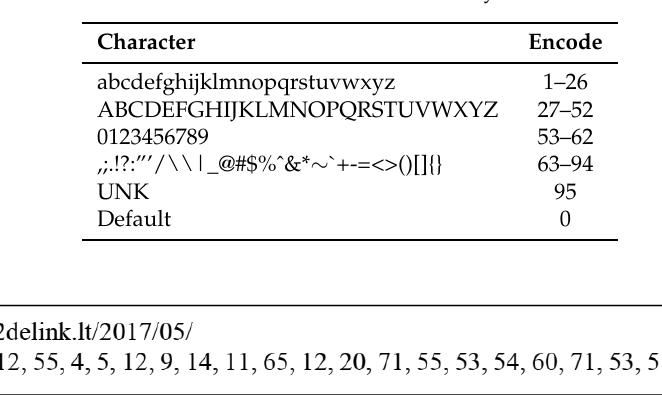
Figure 5. URL index representation example.